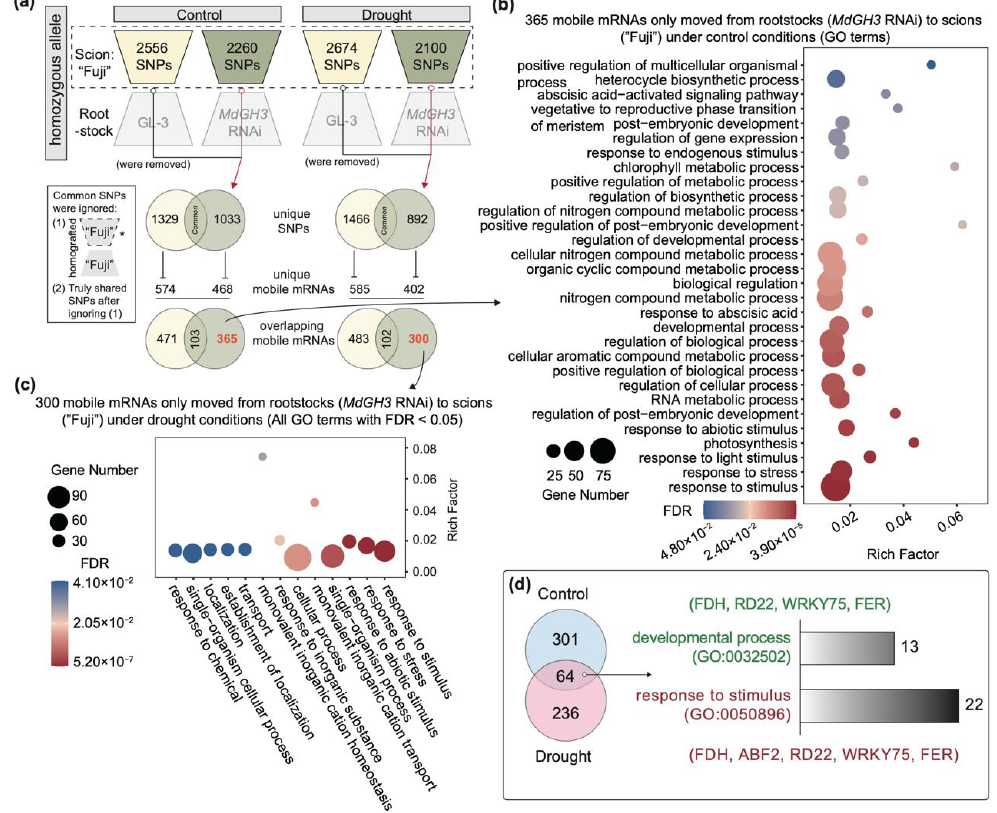
Figure 6. Detection of mRNA movement from control and drought-treated MdGH3 RNAi rootstock to scion (“Fuji”). ( a ) Movement of mRNAs from control and drought-treated MdGH3 RNAi rootstock to the scion. The pipeline included variant calling and mobile mRNAs detection. Green circles and trapezoidal patterns represent SNPs data and mobile mRNAs (mb-mRNAs) moving from rootstocks MdGH3 RNAi plants to scion. The yellow circles and trapezoidal patterns represent SNPs data and mobile mRNAs moving from rootstock GL-3 to scion. ( b ) GO enrichment analysis of 365 mb-mRNAs moving from MdGH3 RNAi rootstock to scion under control conditions. ( c ) GO terms of 300 mb-mRNAs moving from drought-treated MdGH3 RNAi plants rootstock to drought-treated scion. ( d ) Venn diagram demonstrating that 64 mb-mRNAs moved from MdGH3 RNAi plants to scion under control as well as drought treatment. Barplot showing the two GO terms including “developmental process (GO:0032502)” and “response to stimulus (GO:0050896)”, and the number of mb-mRNAs in them. Green font was used for mb- mRNAs related to “developmental process (GO:0032502)”, and red font was used f or those related to “response to stimulus (GO:0050896)”.